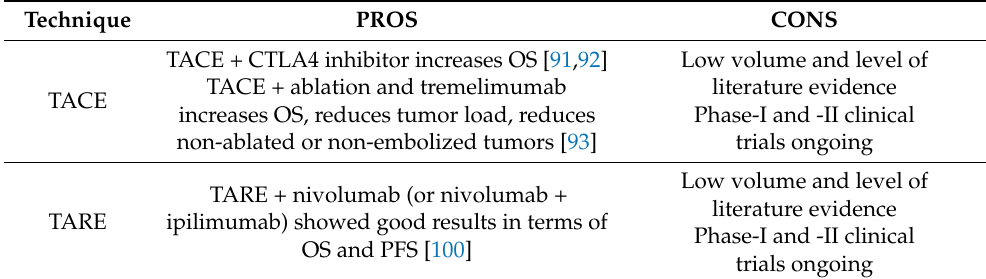
Table 3. Pros and cons of locoregional endovascular interventional oncology treatments plus